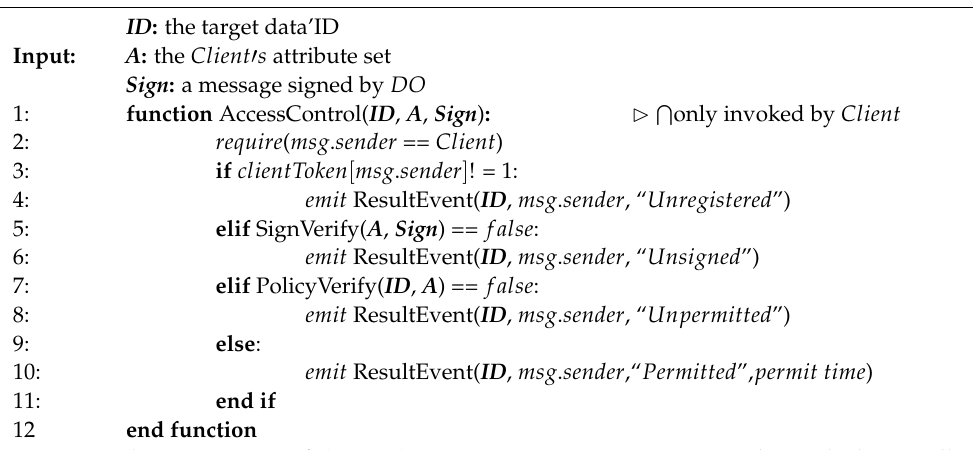
Algorithm 3. Assignment of Client